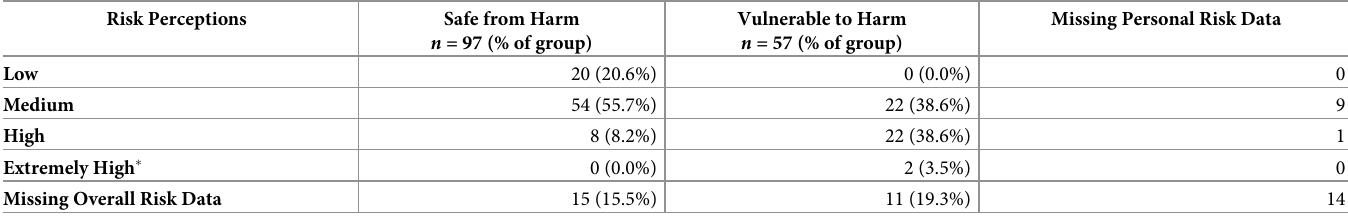
Table 7. Distribution of perceptions of personal risk of harm by perceptions of overall